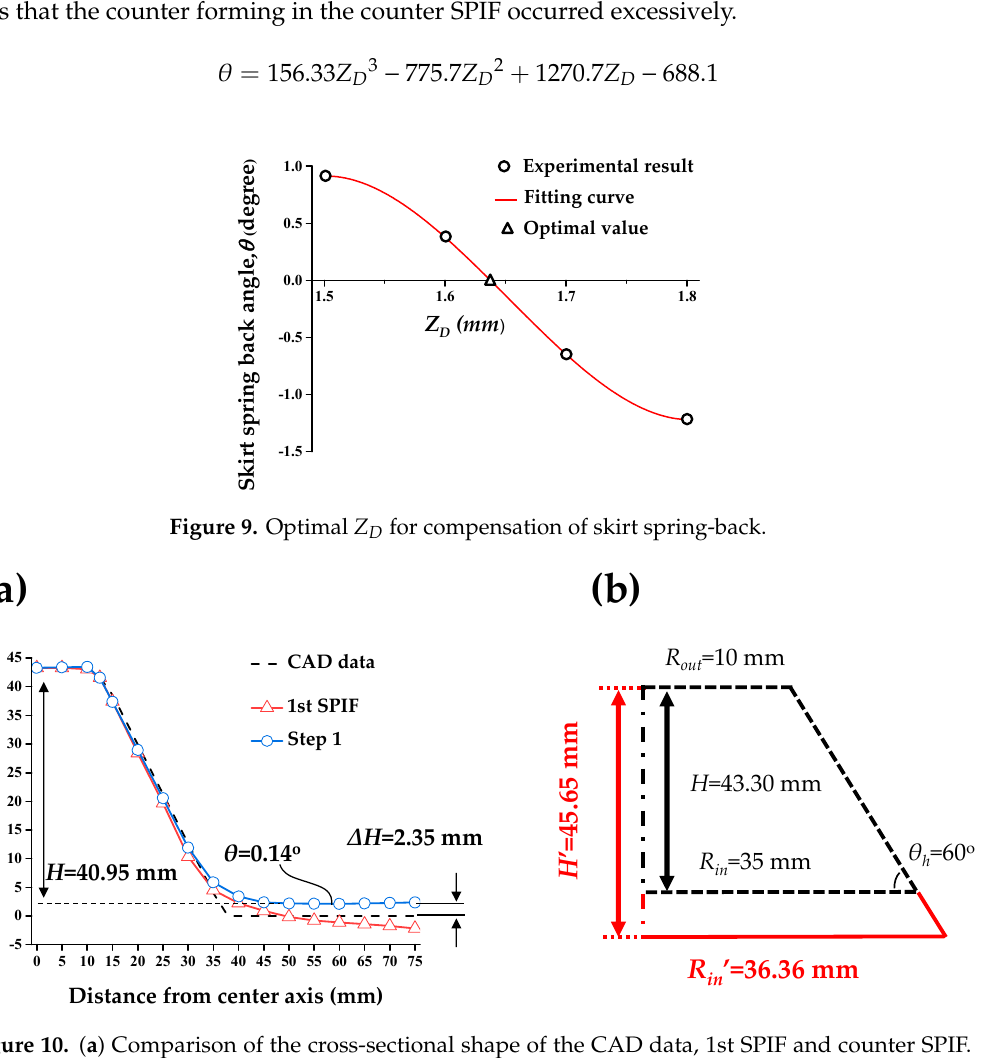
Figure 10. ( a ) Comparison of the cross-sectional shape of the CAD data, 1st SPIF and counter SPIF. ( b ) Modified geometry in the 1st SPIF.